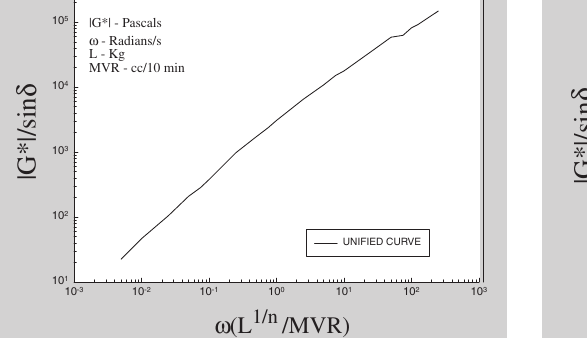
Figure 10 (left): Unified curve of the SHRP parame- ter |G*|/sin d with modified frequency w (L1/n/MVR) at temperatures of 52˚C - 76˚C for polymer-modified unaged asphalt - Novophalt. Figure 11 (right): Comparison of the predicted curve and experimental data for the SHRP parameter |G*|/sin d with frequency w at temper- ature of 64˚C for polymer- modified unaged asphalt -